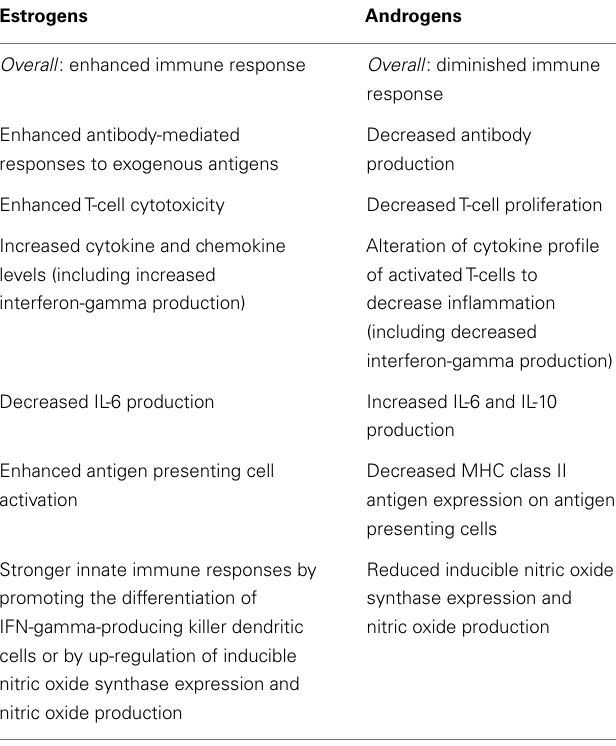
Table 4 | Effects of sex hormones on immune